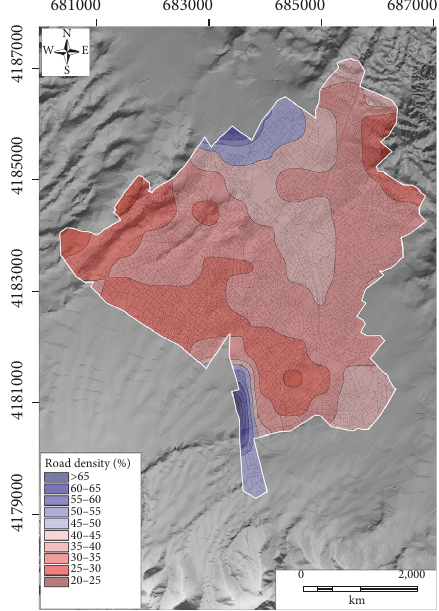
Figure 4: Road density map.